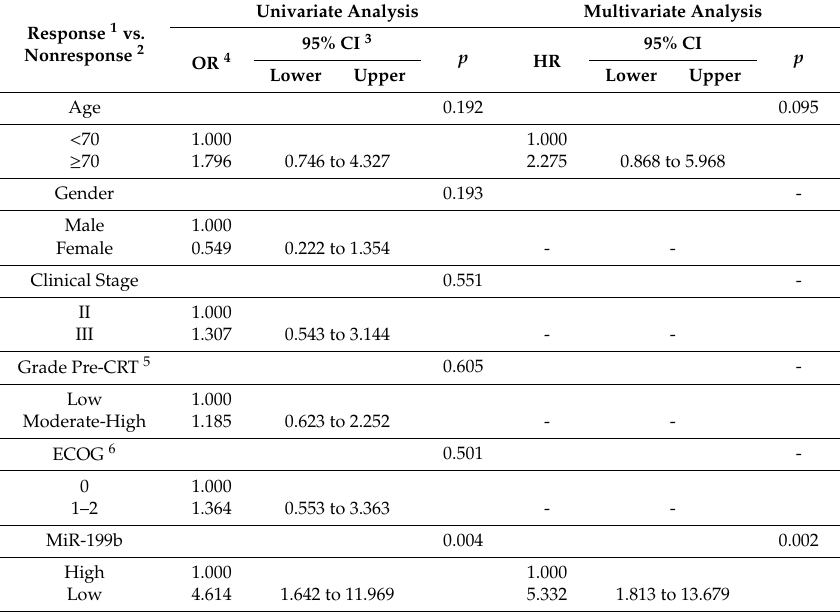
Table 3. Univariate and multivariate logistic analyses for pathological response in 82 LARC